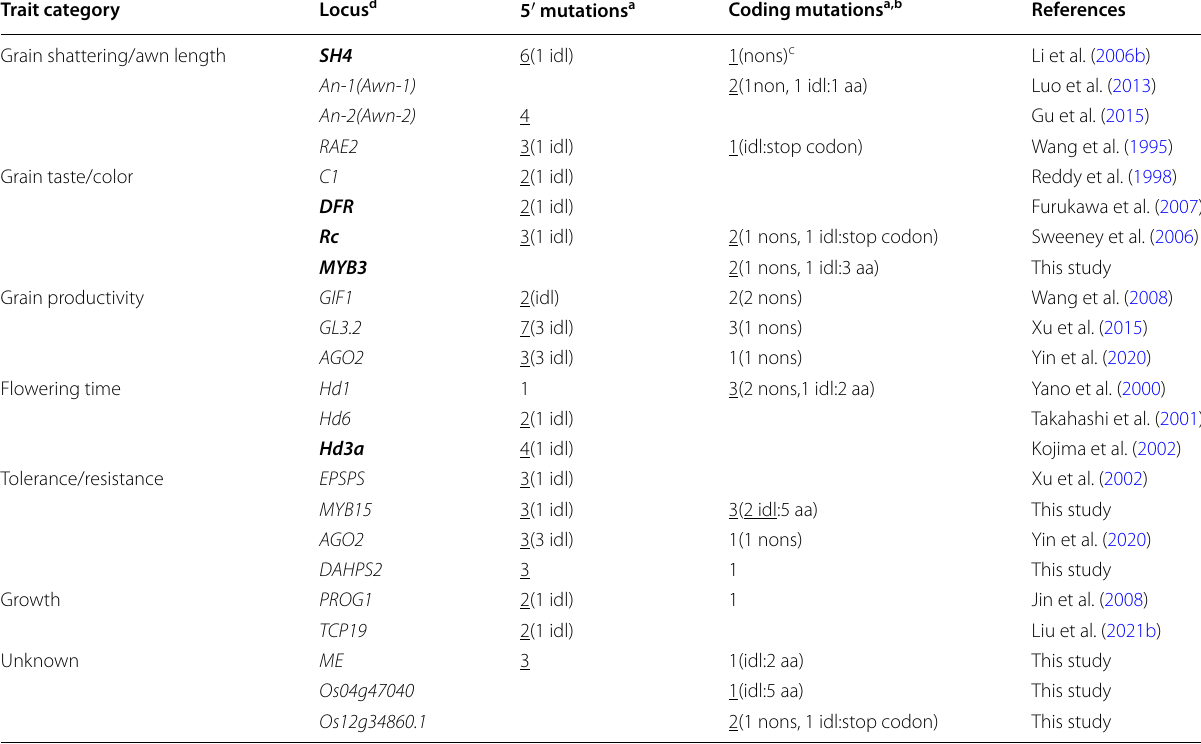
Table 1 Sampled O. sativa loci under positive selection during the early domestication